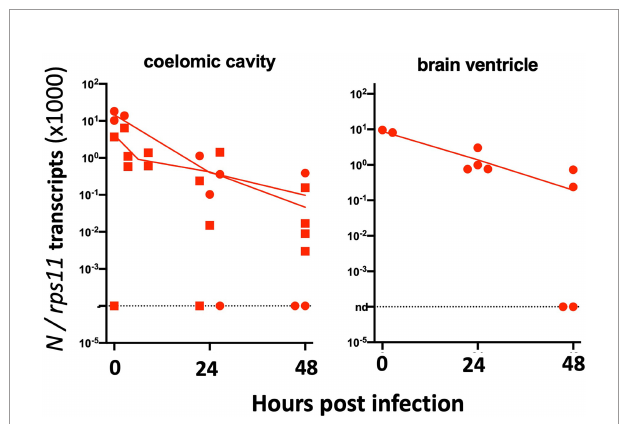
FIGURE 10 | Injection of 3-dpf hACE2-mCherry mosaic larvae. Quanti fi cation of sense N transcripts in individual hACE2-mCherry mosaic larvae injected in coelomic cavity (left; one experiment with hACE2-mCherry, one with hACE2- 2A-mCherry) or brain ventricle (right; with hACE2-2A-mCherry) by qRT-PCR.